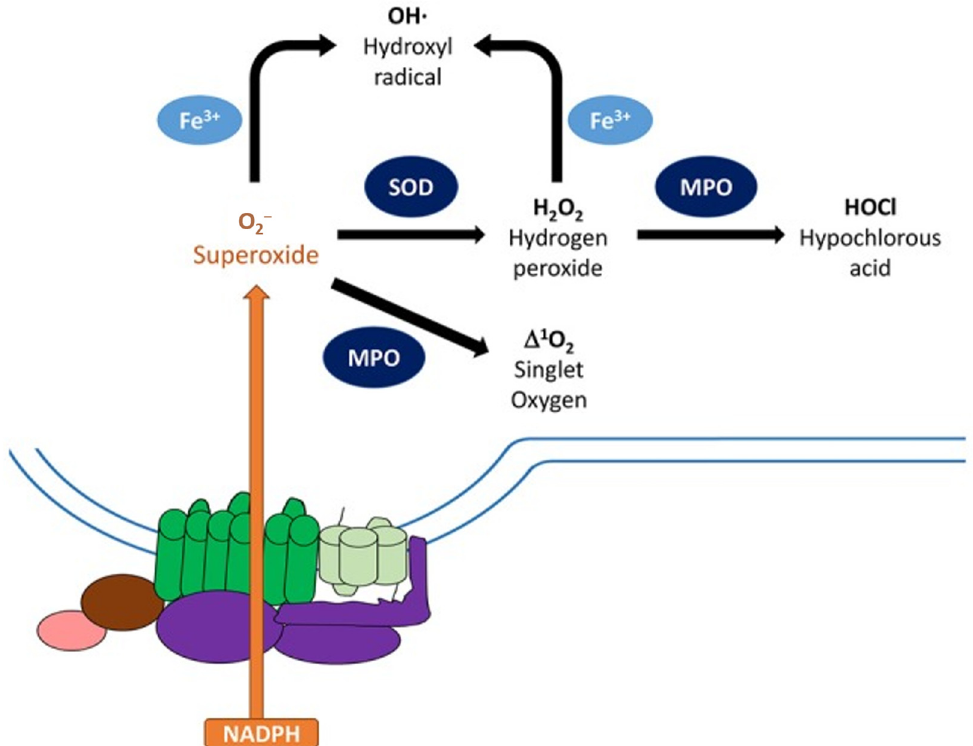
Figure 10. Biochemical reactions involved in reactive oxygen species (·O 2 − , ·OH, H 2 O 2 , singlet oxy- gen, and HOCl) formation during inflammation. Reproduced (adapted) with permission from [261].